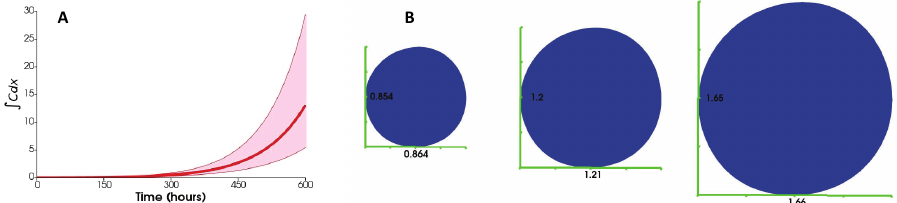
Figure 12. ( A ) The variation of the total number of cancer cells as a result of 10% perturbation of the most sensitive parameters. ( B ) The leftmost circle corresponds to the lower bound, the middle circle corresponds to the thick solid red curve and the right circle corresponds to the upper bound of the graph in ( A